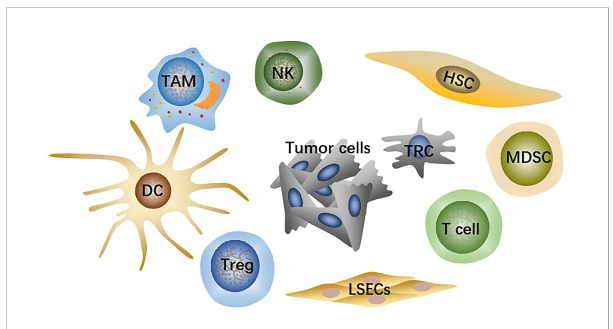
FIGURE 1 The main cell types in TME include tumor cells, effector T cells, NK cells, dendritic cells (DCs), hepatic stellate cells (HSCs), liver sinusoidal endothelial cells (LSECs), tumor-associated macrophages (TAMs), regulatory T cells (Tregs), myeloid-derived suppressor cells